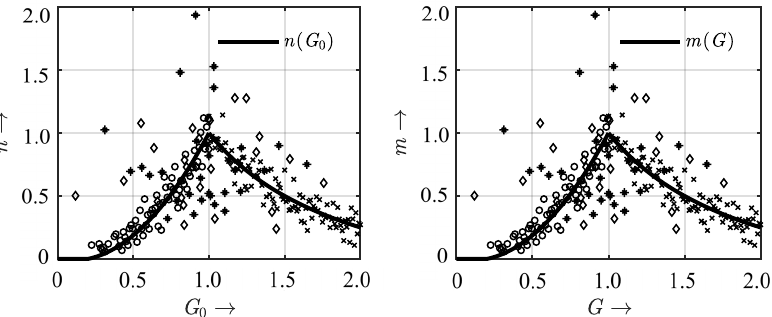
Figure 1. Combined results of various configurations, voltage forms and test sites (qualitatively): Functions n ( G 0 ) after [19] ( left ) and m ( G ) after [20] respective [21] ( right ).